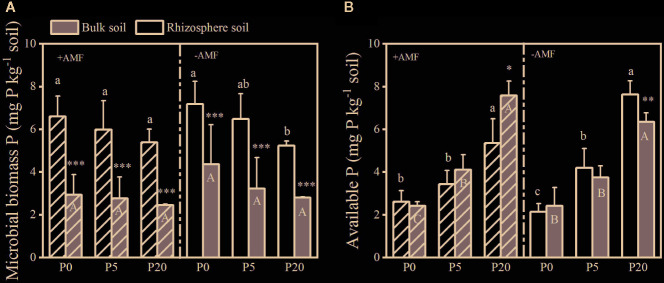
Microbial-biomass P (A) and available P (B) in the rhizosphere soil and bulk soil. Data are presented as means ± S.E. (n = 4). One-way ANOVA and Tukey’s test were performed in the +AMF and −AMF treatments separately for the bulk soil and rhizosphere soil. Lower-case letters indicate significant differences between the rhizosphere soil, and upper-case letters indicate significant differences between the bulk soil. One-way ANOVA significance (P < 0.05) to test for significant differences between the bulk soil and rhizosphere soil for each treatment is indicated by *. *P < 0.05; **P < 0.01; ***P < 0.001.